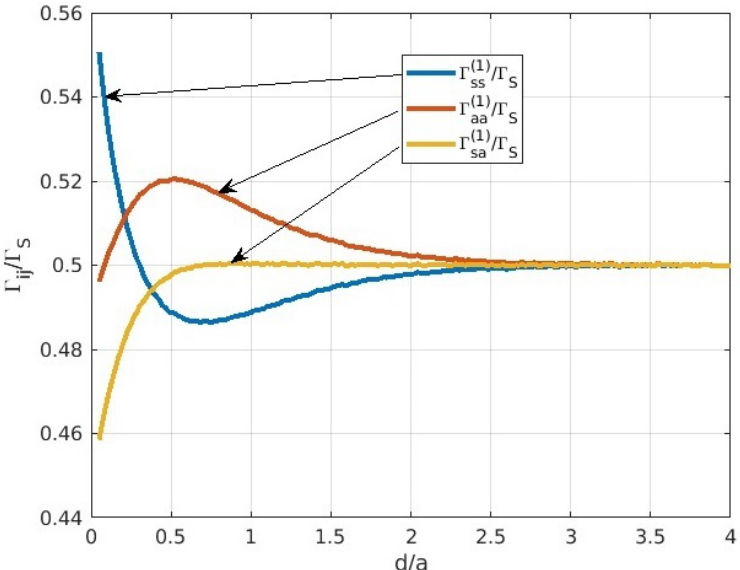
Figure 3. Plot of the overlap factors relative to Γ S for a weakly-guiding ( v = π /2) symmetric slab structure as a function of spatial separation between the guides. Here, 2 d is the edge-to-edge separation between the guides and 2 a is the guide width (8 µ m in this case). Only the overlap factors for guide ( 1 ) are shown. The factors for guide ( 2 ) are the same, except that Γ